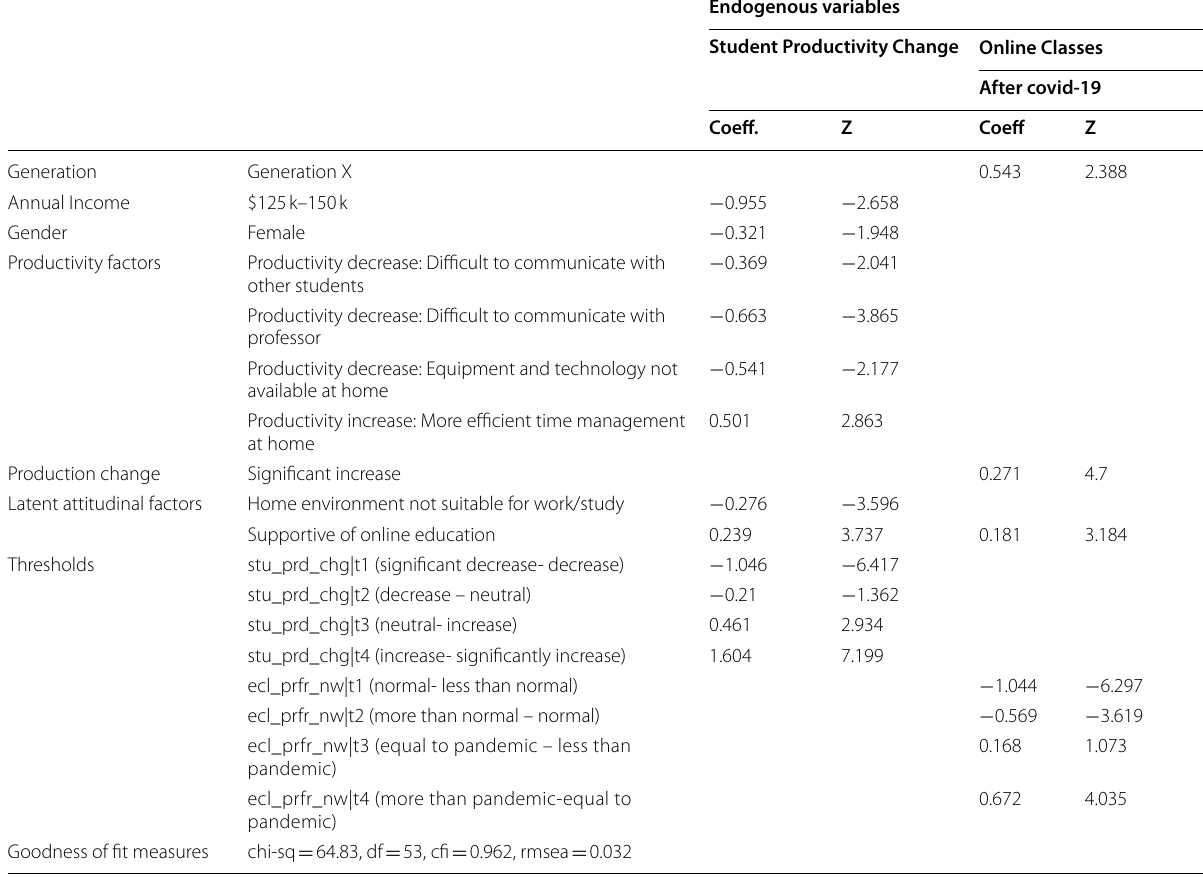
Table 2 Results of the structural